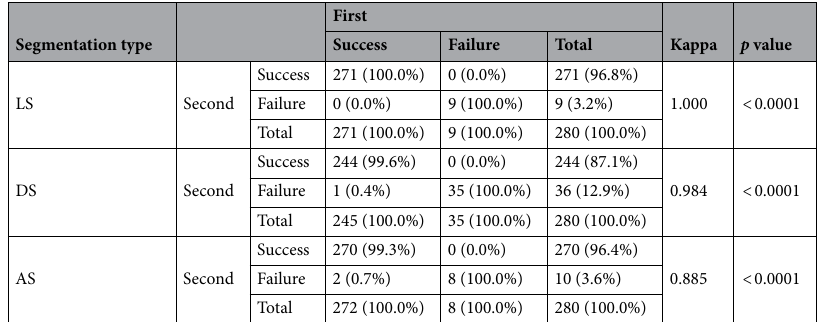
Table 2. Kappa statistics of agreement of measurement results on success/failure of tooth segmentation. Success and failure of segmentation, presented as nominal variables using Cohen’s kappa, indicated very high evaluation reproducibility from 0.885 to 1.000. Kappa values were interpreted as follows: poor, < 0.0; slight, 0.0 to 0.2; fair, 0.2 to 0.4; moderate, 0.4 to 0.6; substantial, 0.6 to 0.8, and almost perfect, 0.8 to 1.0.